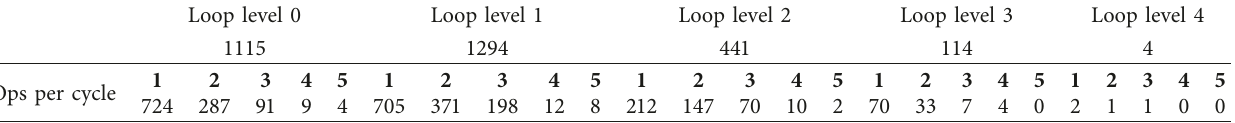
Table 6: Distribution of Speex arithmetic-move instructions based on loop level and number of operations per cycle (1–5).